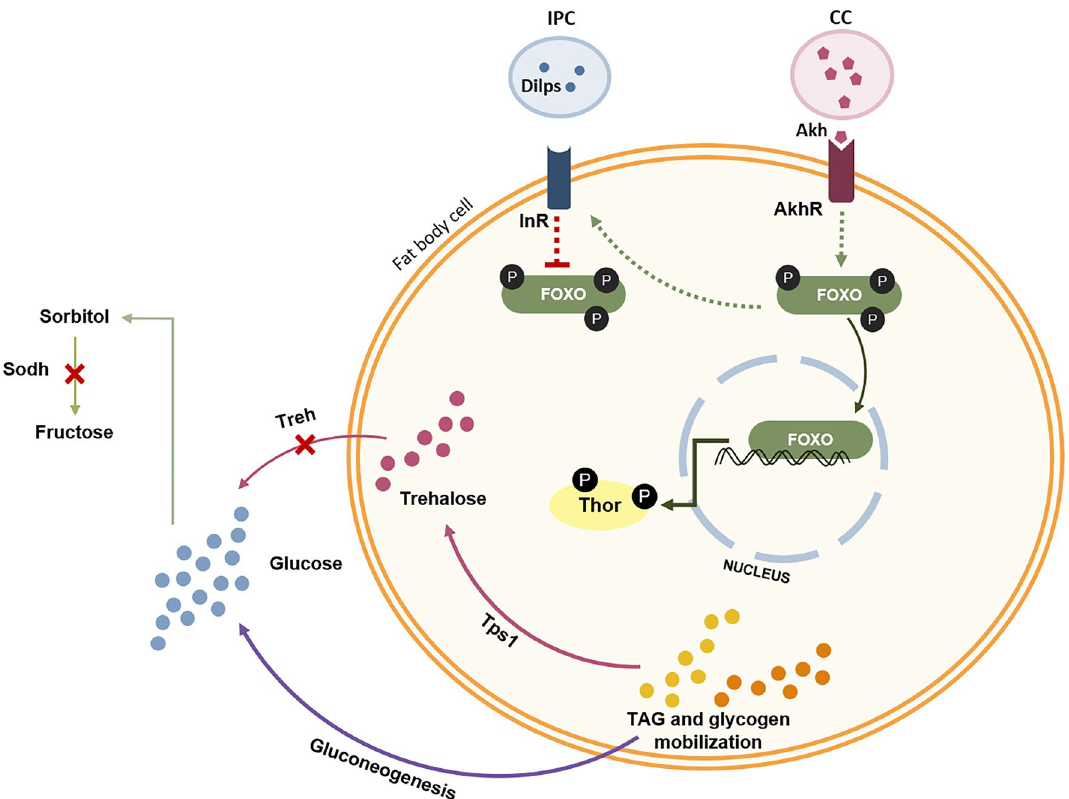
Figure 5. Schematic representation of the proposed hypothesis on the modulation of males’ metabolism after feeding on raspberry fruit medium. Nutrient deficiency, specifically carbohydrate deficiency, activates the production of Adipokinetic hormone (Akh) in the Corpora Cardiaca (CC) which will bind to the Akh receptor (AkhR), promoting the dephosphorylation of the Forkhead box O (FOXO) transcription factor and mobilization to the nucleus. This will promote TAG and glycogen mobilization for glucose production by gluconeogenesis, and trehalose production by trehaloneogenesis mediated by Trehalose-6-phosphate synthase 1 (Tps1). Due to low sugar content in raspberry, there is a need to increase glucose and trehalose levels, therefore the expression of Trehalase (Treh) and sorbitol dehydrogenase (Sodh) remain unchanged. Simultaneously, there is a feedback activation of the insulin receptor (InR) by FOXO, in order to maintain the receptor more prone to binding of the Drosophila insulin-like peptides (Dilps) produced by the insulin-producing cells (IPC) after the detection of higher levels of